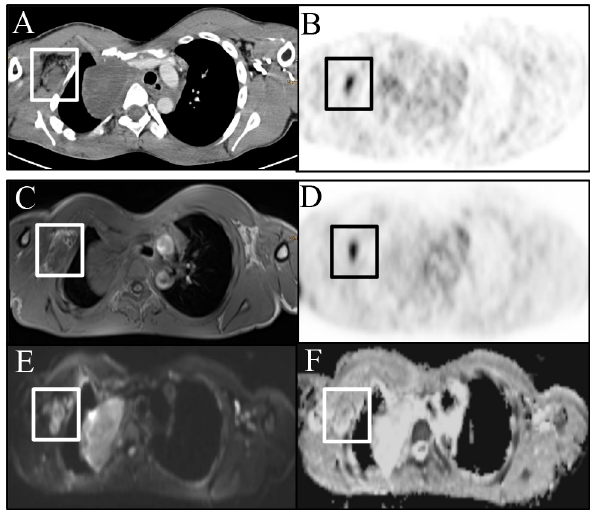
Fig 3. PNST in a 17-yearmale patient. (A) Peripheral nerve sheath tumor depictedon CE-CT image with (B) increasedglucosemetabolism. (C) CorrespondingT1w image. (D) [18F]-FDG-PET depictingincreased glucoseuptake and correspondingrestricted diffusionon (E) DWI (b800) image with (F) loweredsignal on the ADC map.